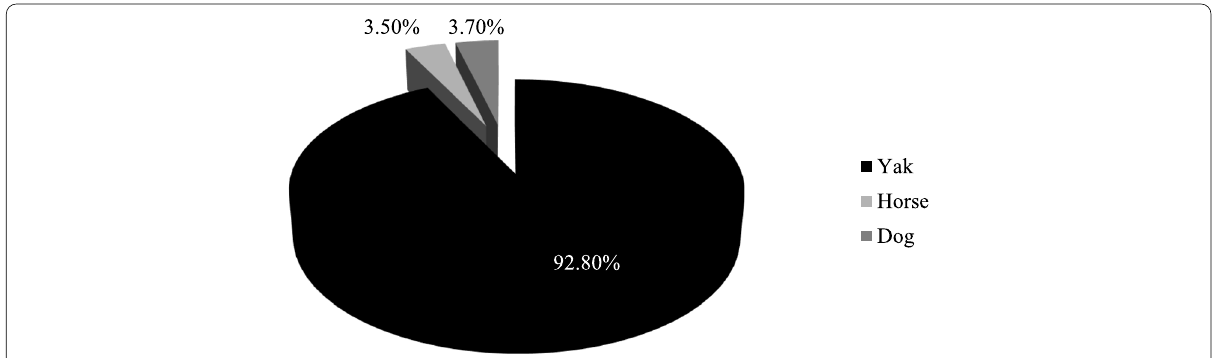
Fig. 2 Livestock depredation composition of herders